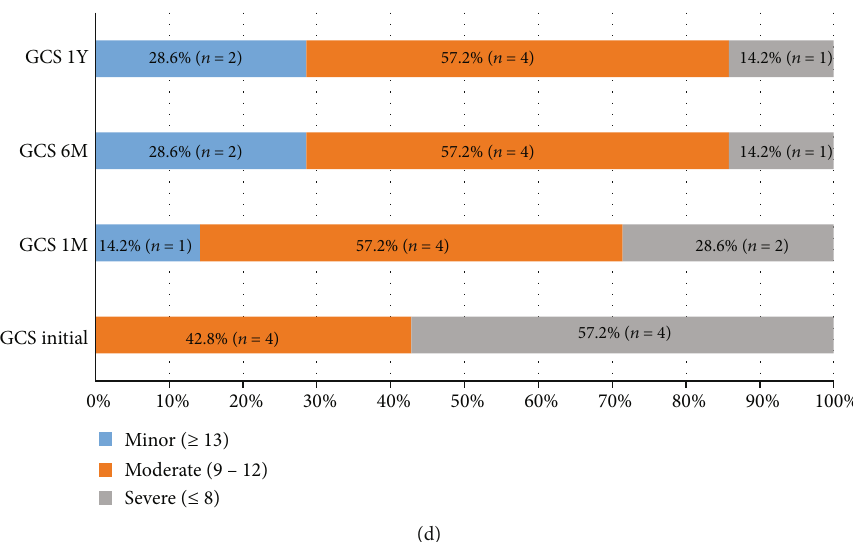
Figure 1: Distribution of functional outcomes. (a) Functional outcomes of the MIS group. (b) Functional outcomes of the EVD group. (c) Glasgow Coma Scale score of the MIS group. (d) Glasgow Coma Scale score of the EVD group.